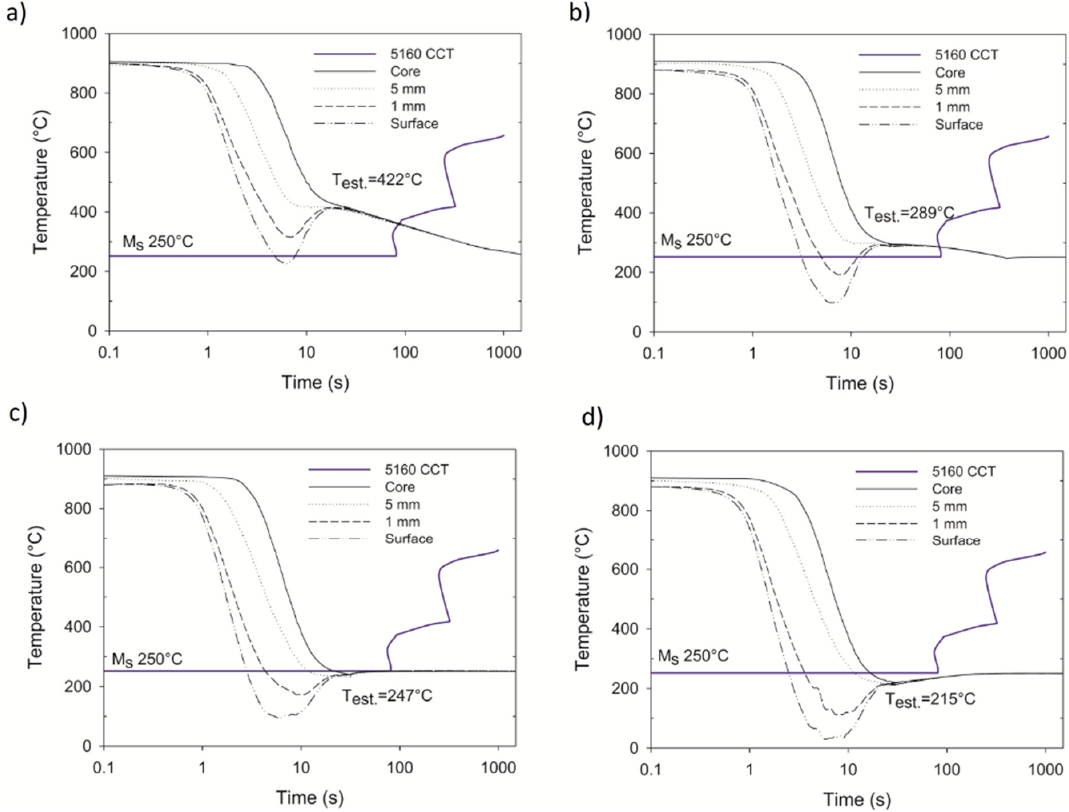
Figure 6. Cooling curves obtained in the high-speed chamber for ( a ) 2, ( b ) 3, ( c ) 4, and ( d ) 5 s.